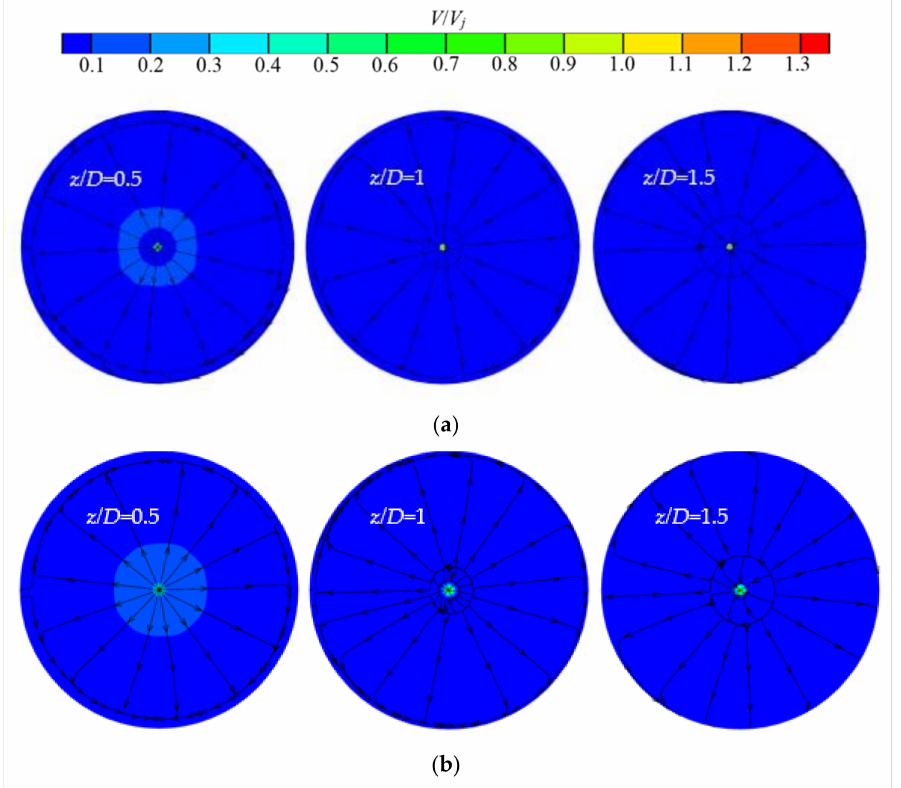
Figure 12. Flow structure diagram of different cross-sections of continuous jet impinging on stationary wall: ( a ) H/D = 2; ( b ) H/D =